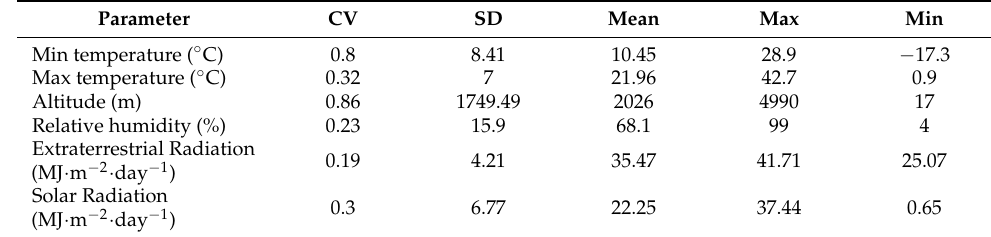
Figure 1. Geographic location of the study area and meteorological stations used in this study. Table 1. Statistical indices for climatic parameters recorded in 13 Peruvian meteorological stations over the time period covered in this